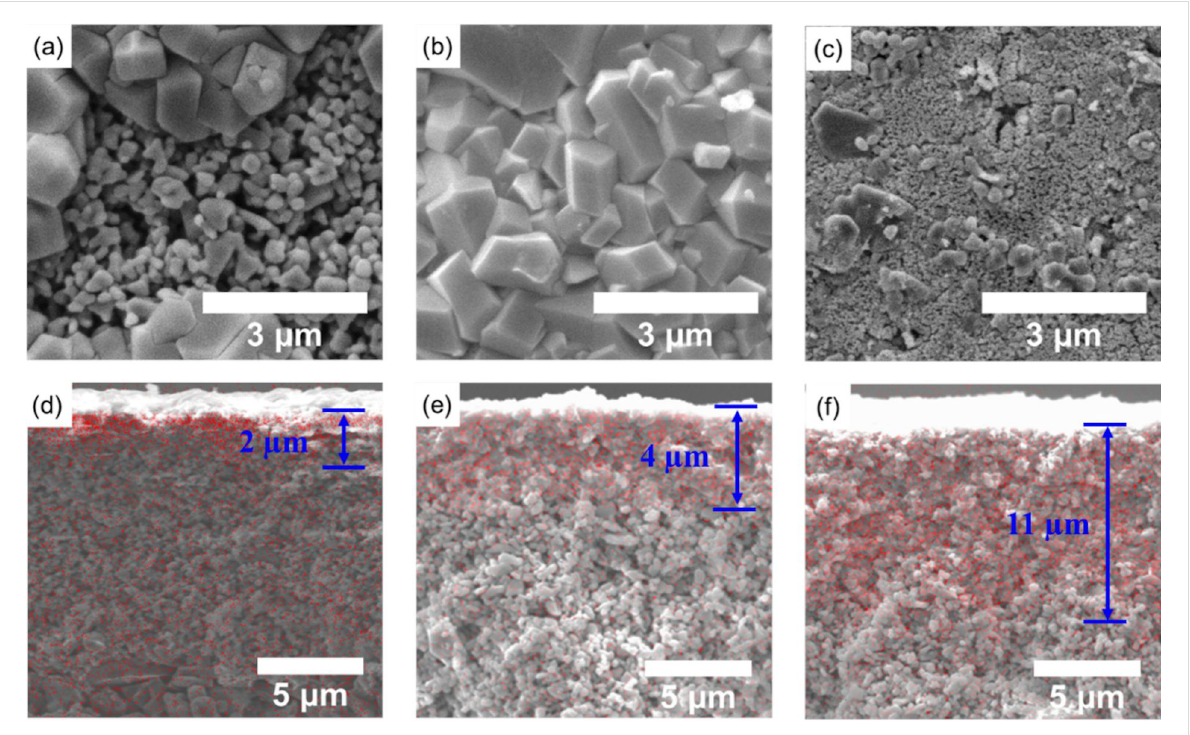
Figure 5: Top-view SEM images of ZIF-8 membranes fabricated with 2-methylimidazole/1-octanol solution concentration of (a) 25 mM, (b) 50 mM, and (c) 400 mM after 12 h at 80 °C. Cross-sectional EDS mappings of ZIF-8 membranes fabricated with 2-methylimidazole/1-octanol solution con- centration of (a) 25 mM, (b) 50 mM, and (c) 400 mM after 12 h at 80 °C.